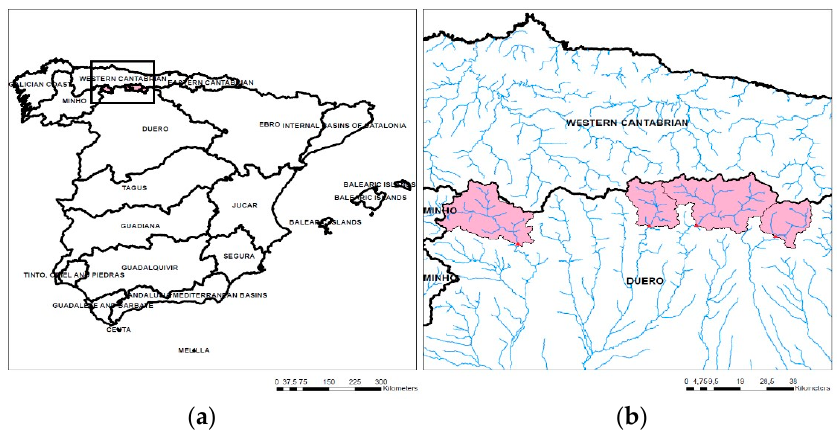
Figure 1. ( a ) Location of the case studies in Spain; ( b ) Catchments of the four case studies.